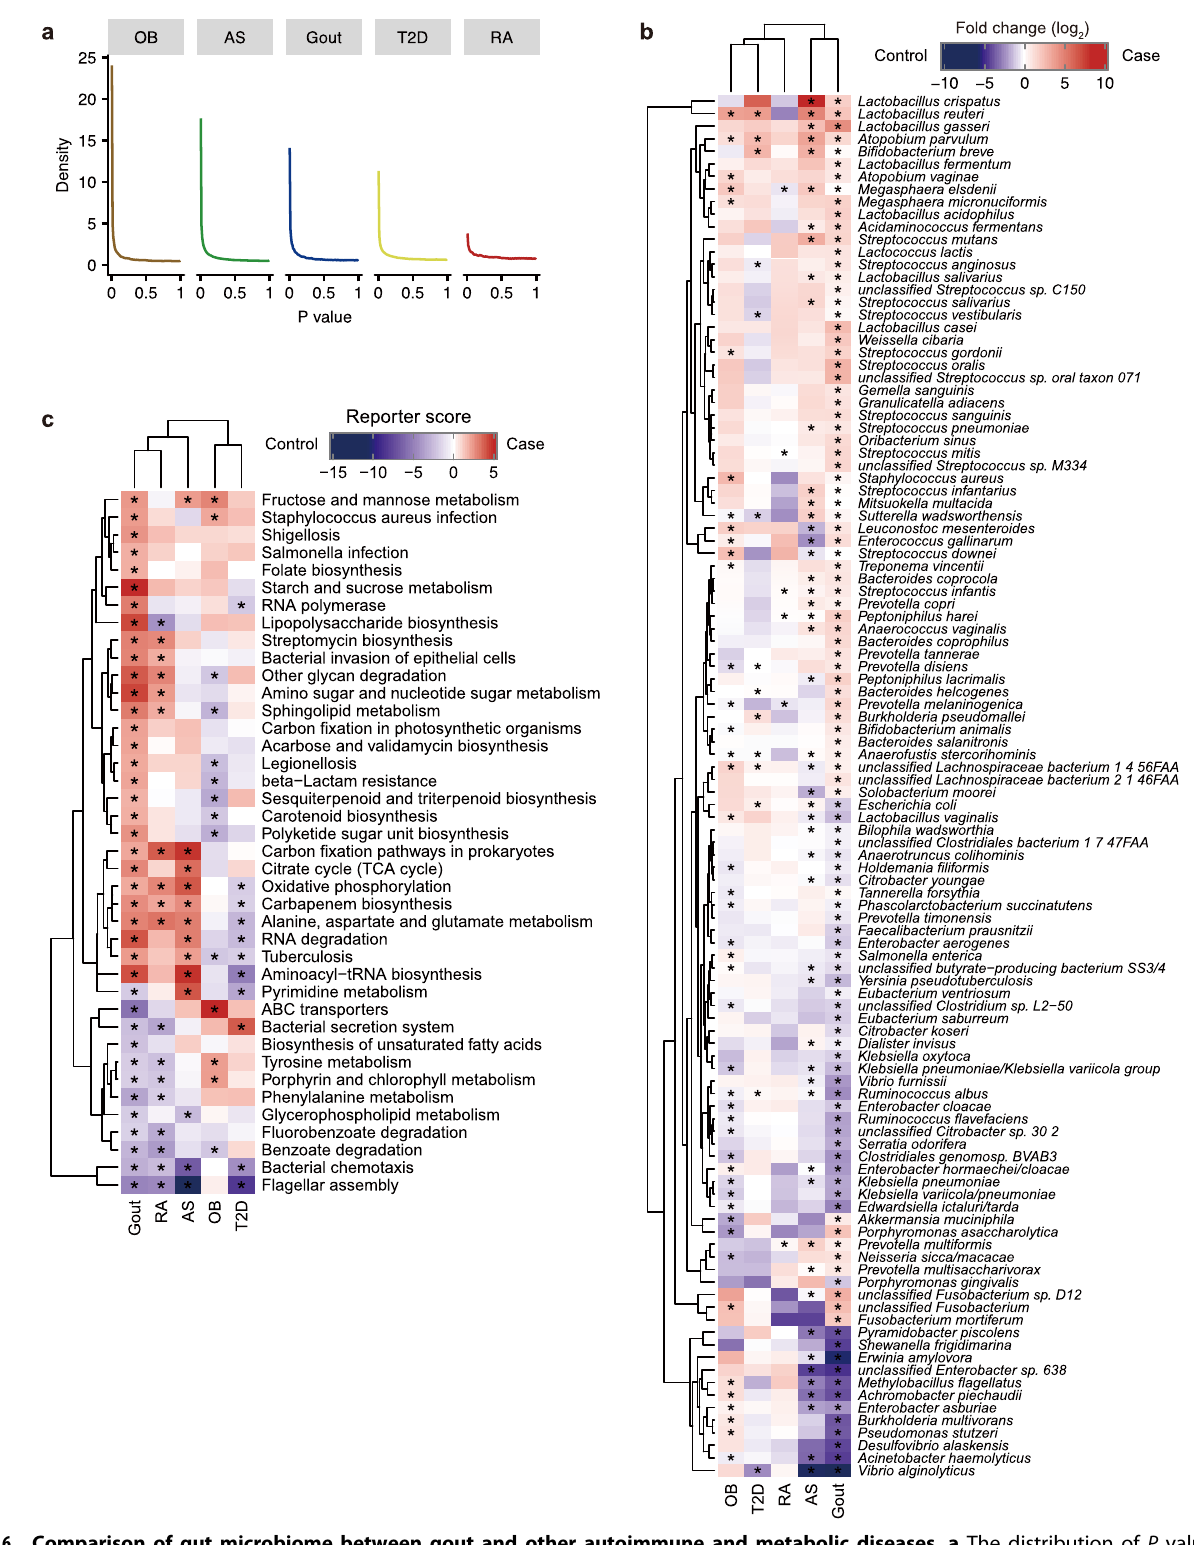
Fig. 6 Comparison of gut microbiome between gout and other autoimmune and metabolic diseases. a The distribution of P values by Wilcoxon rank-sum test for all microbial genes in case-control comparison within each of the AS ( n = 211), gout ( n = 140), OB ( n = 200), RA ( n = 169), and T2D ( n = 268) datasets. b Comparison of differential species in AS, gout, OB, RA and T2D. Purple, enriched in healthy controls; red, enriched in patients; Wilcoxon rank-sum test: asterisk denotes FDR P < 0.05. c Comparison of microbial gene functions in AS, gout, OB, RA and T2D. Purple, enriched in healthy controls; red, enriched in patients. Asterisk denotes reporter score of pathways > 1.65 or < −